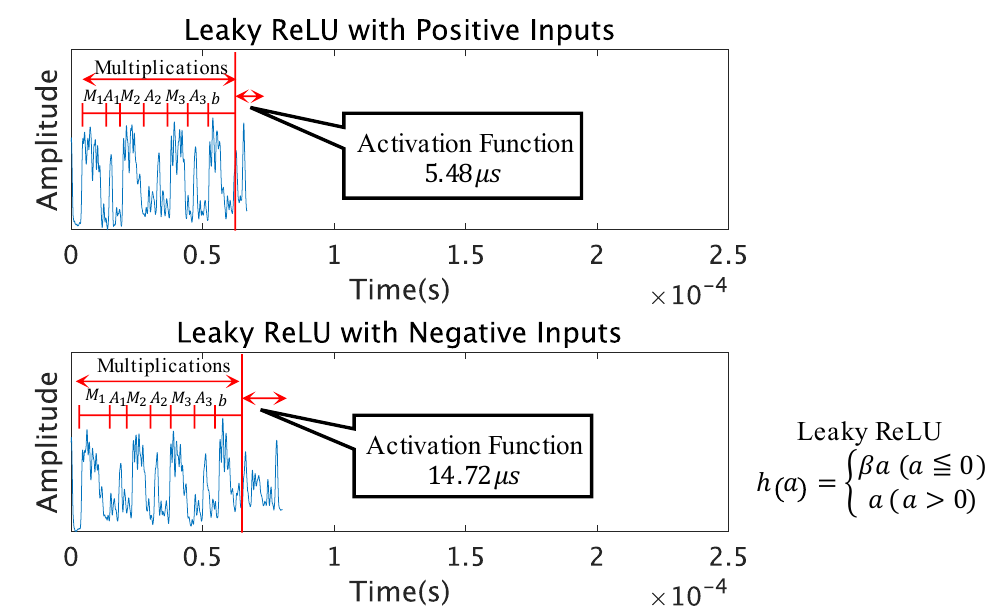
Figure 7. Extracted Pattern Measurements of the Leaky ReLU